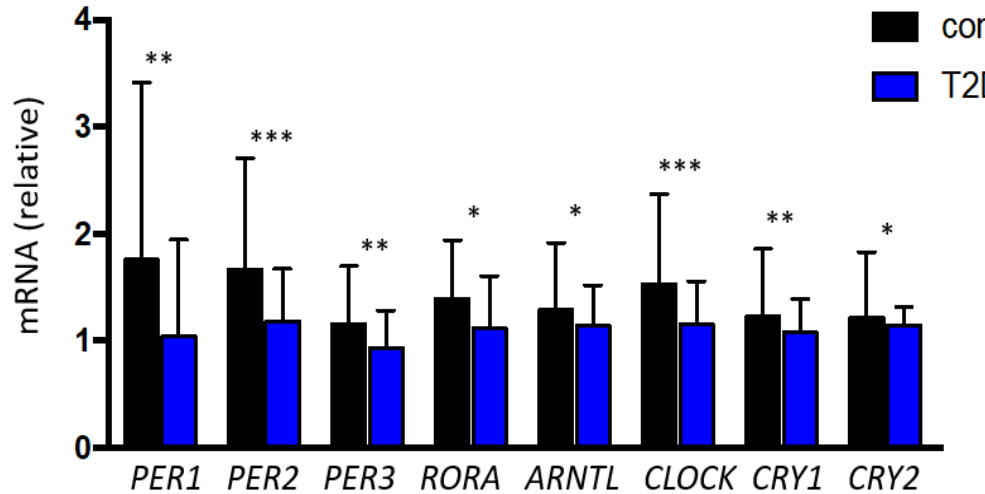
Figure 2. Relative gene expression of the clock genes evaluated in the study according to the presence of type 2 diabetes. Data are presented as median and interquartile. *** p < 0.001; ** p < 0.01; * p < 0.05. PER: Period Homolog Proteins; RORA: Retinoid-related Orphan Receptor Alpha; ARNTL: Aryl hydrocarbon Receptor Nuclear Translocator-Like protein-1; CLOCK: Circadian Locomotor Output Cycles Kaput; CRY: Cryptochrome proteins; T2D: type 2 diabetes.